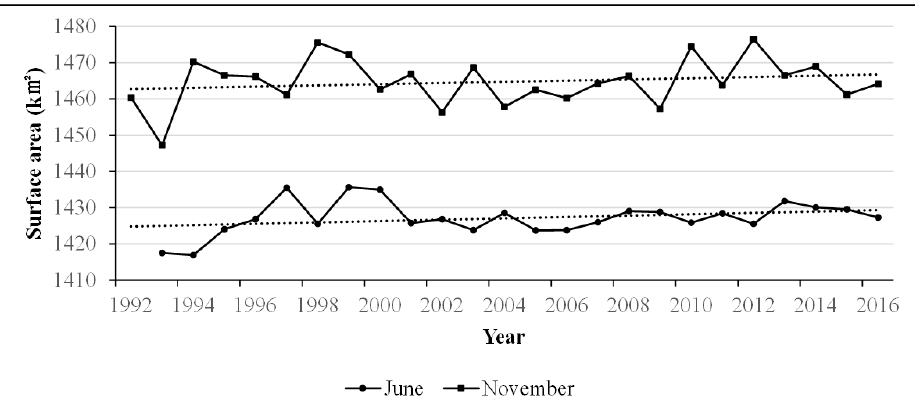
Figure 14. Monthly average lake surface area of the SPLC from 1992 to 2016.